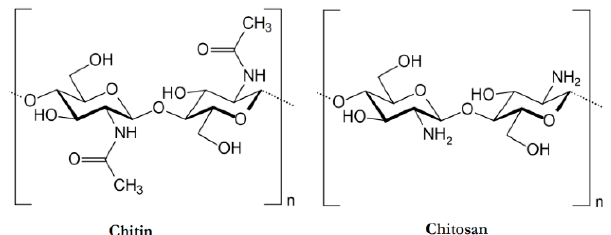
Figure 9. An illustration of the chemical structures of Chitin and Chitosan [90].